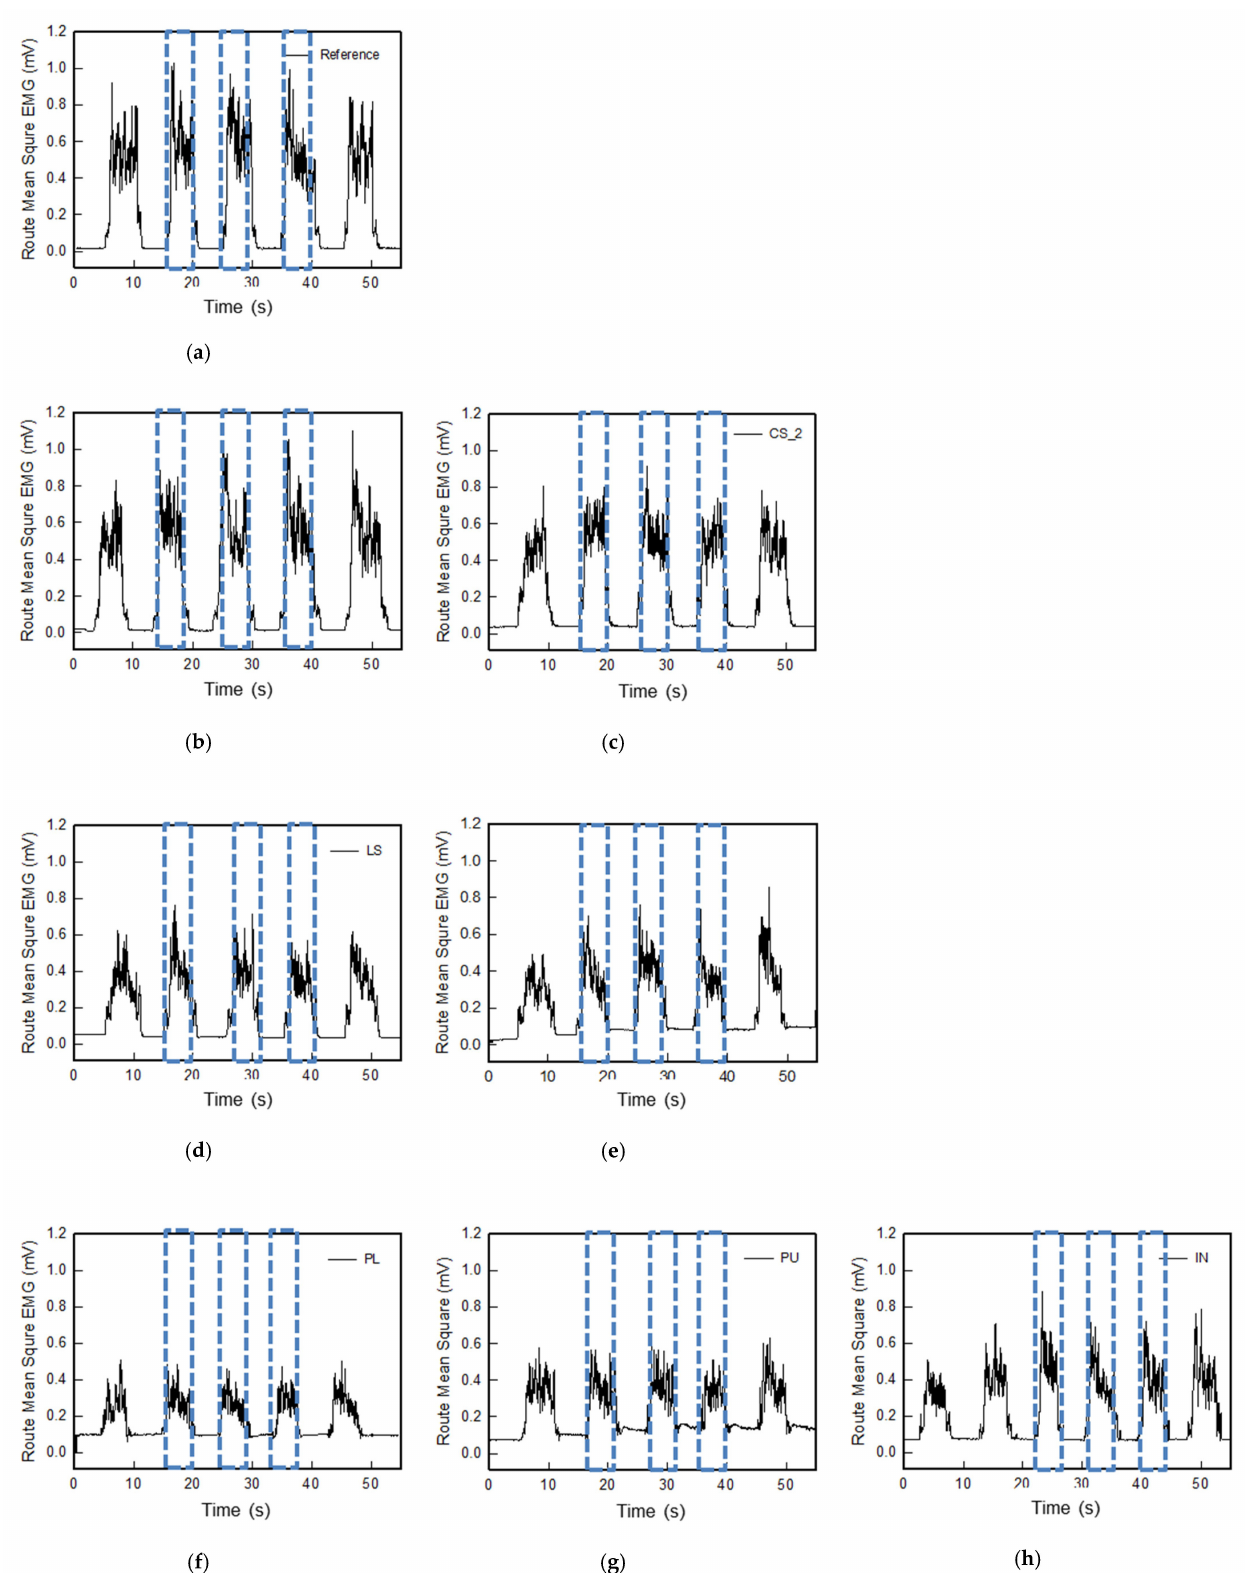
Figure 7. Graph of filtered (20–500 Hz) in analog and full-wave of sEMG signals obtained via various electrodes; ( a ) reference, ( b ) CS_1, ( c ) CS_2, ( d ) Em_LS, ( e ) Em_MS, ( f ) Kn_PL, ( g ) Kn_PU, and ( h ) Kn_IN,